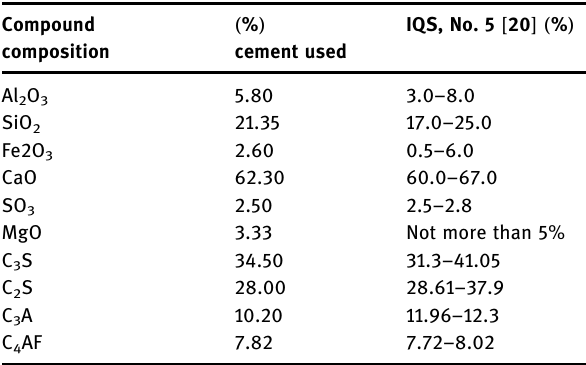
Table 2: Chemical analysis of cement